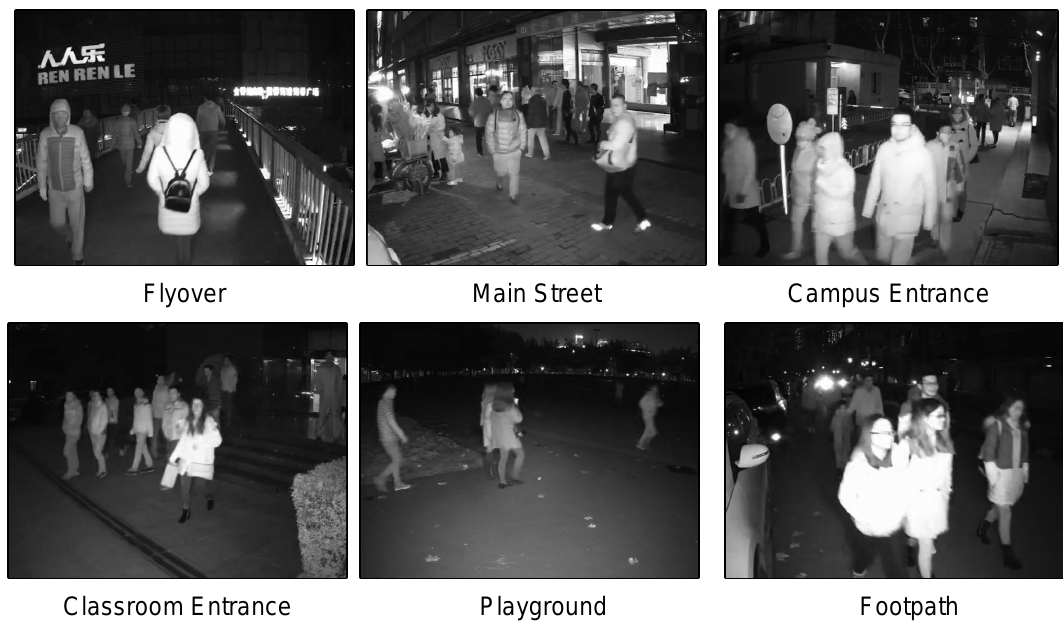
Figure 1. Examples of our stereo nighttime pedestrian dataset, which includes flyover, main street, campus entrance, building entrance, playground and footpath. Note that besides low illumination, less texture information and blurred contours, these scenes also contain severe mutual occlusion between the human